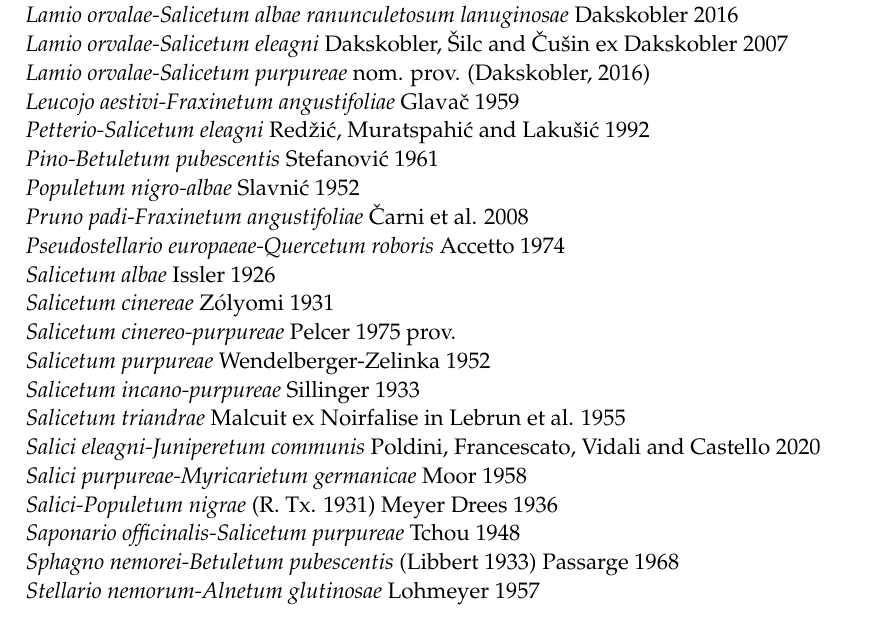
Table A1. Synoptic table for the cluster group Salicetea purpureae . Frequencies of species are presented as percentages with phi values multiplied by 100 shown in superscript. Diagnostic species (phi values higher than 0.30) are shaded. Species with frequency lower than 30% in a cluster for which they are diagnostic are not shown. Only up to 15 species with the highest phi value are presented.